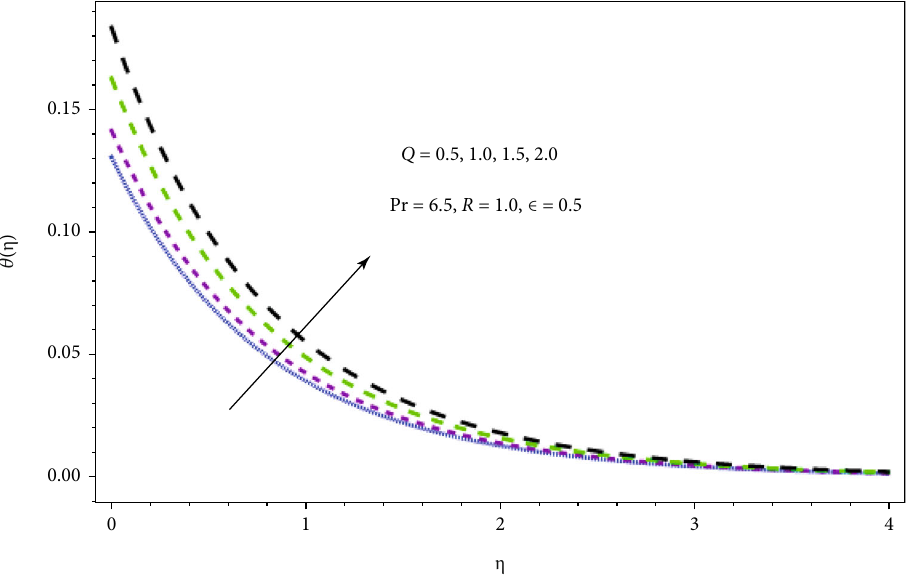
Figure 6: Illustration of the e ff ect of Q on θ ð η Þ .